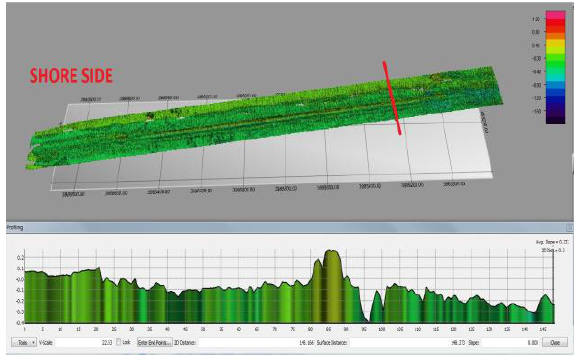
Figure 14: Change detection profile of deeper water part.